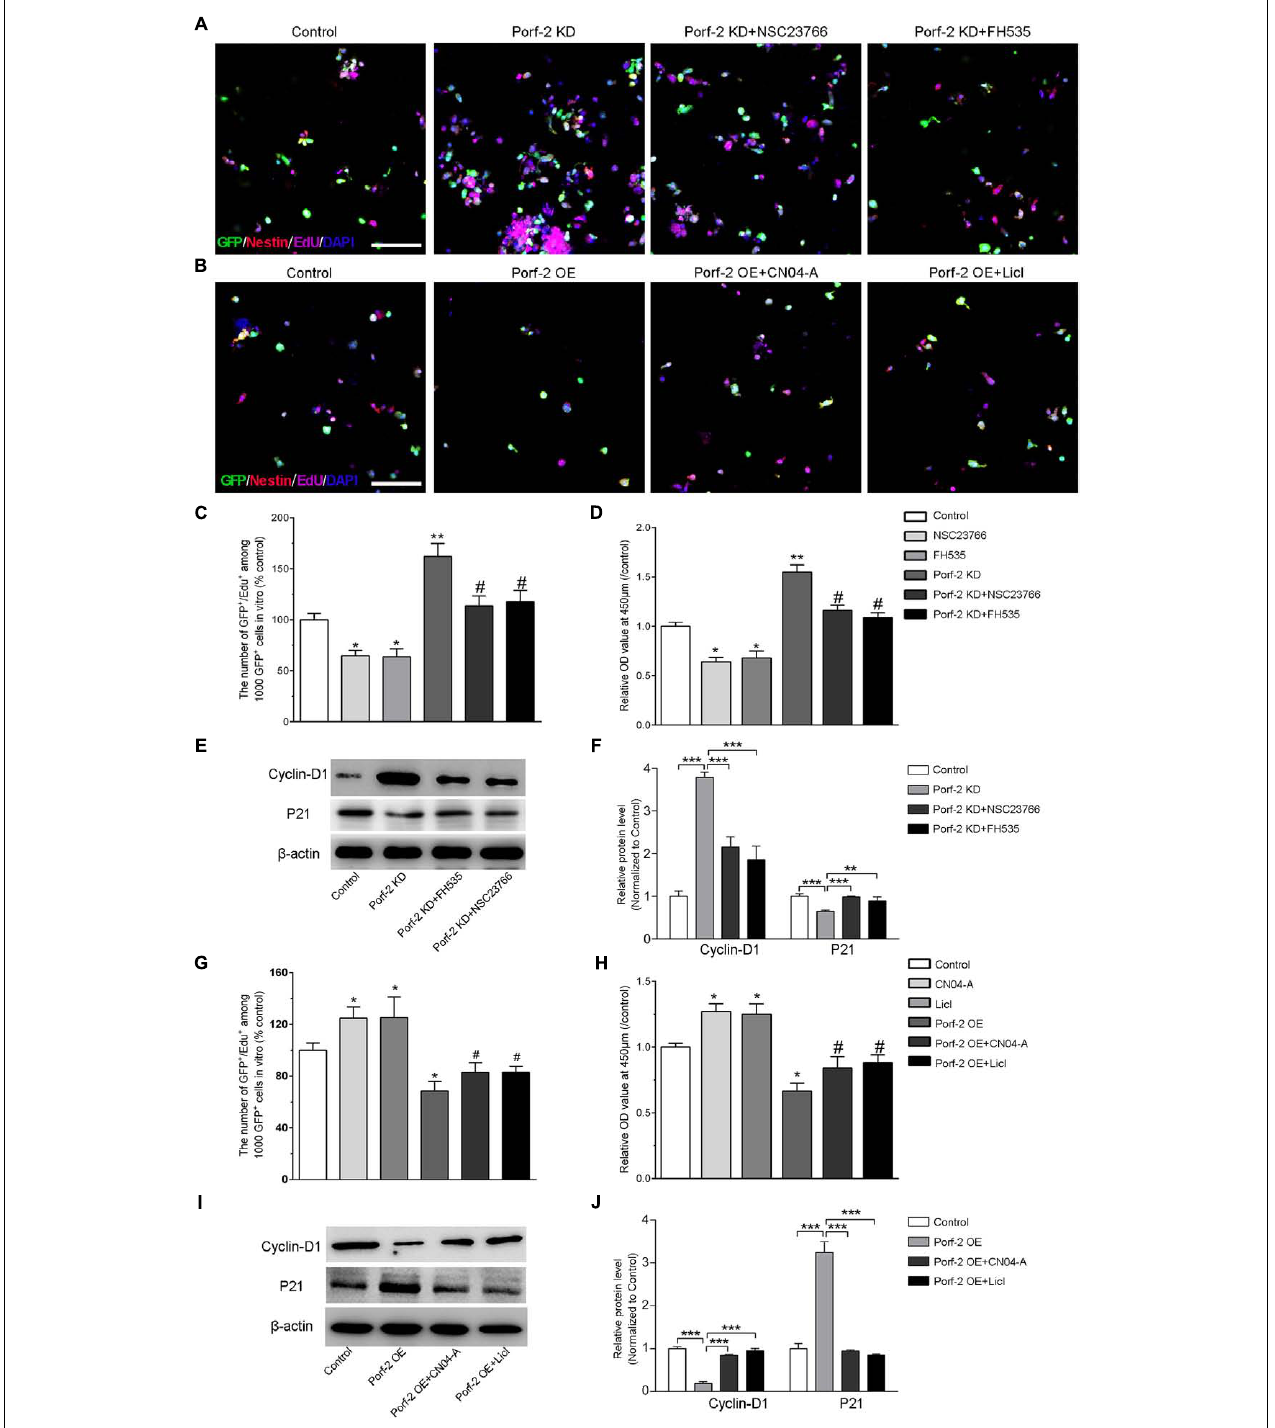
FIGURE 4 | Effect of Porf-2 knockdown or overexpression on NSCs proliferation via the Rac1-Wnt/ β -catenin pathway. (A,B) Representative photographs of proliferation of EdU-positive NSCs. Porf-2 knockdown and Porf-2-overexpression NSCs were treated with a Rac1 activator (CN04-A), Rac1 inhibitor (NSC23766), Wnt activator (LiCl), or β -catenin/TCF inhibitor (FH535). Scale bar: 100 µ m. (C,D,G,H) The relative proliferation ratio of EdU-positive NSCs and CCK8 assay. The relative proliferation ratios are represented in Porf-2 knockdown and Porf-2-overexpression NSCs, which were treated with a Rac1 activator (CN04-A), Rac1 inhibitor (NSC23766), GSK-3 β inhibitor (LiCl), or β -catenin/TCF inhibitor (FH535). (C,D) ∗ p < 0.05, ∗∗ p < 0.01 vs. control. # p < 0.05 vs. Porf-2 KD. (G,H) ∗ p < 0.05 vs. control. # p < 0.05 vs. Porf-2 OE. (E,F,I,J) The effect of activators or inhibitors of Rac1 or the Wnt/ β -catenin signaling pathway on Porf-2 knockdown or overexpression NSCs growth and proliferation-associated proteins. ∗∗ p < 0.01, ∗∗∗ p < 0.001.